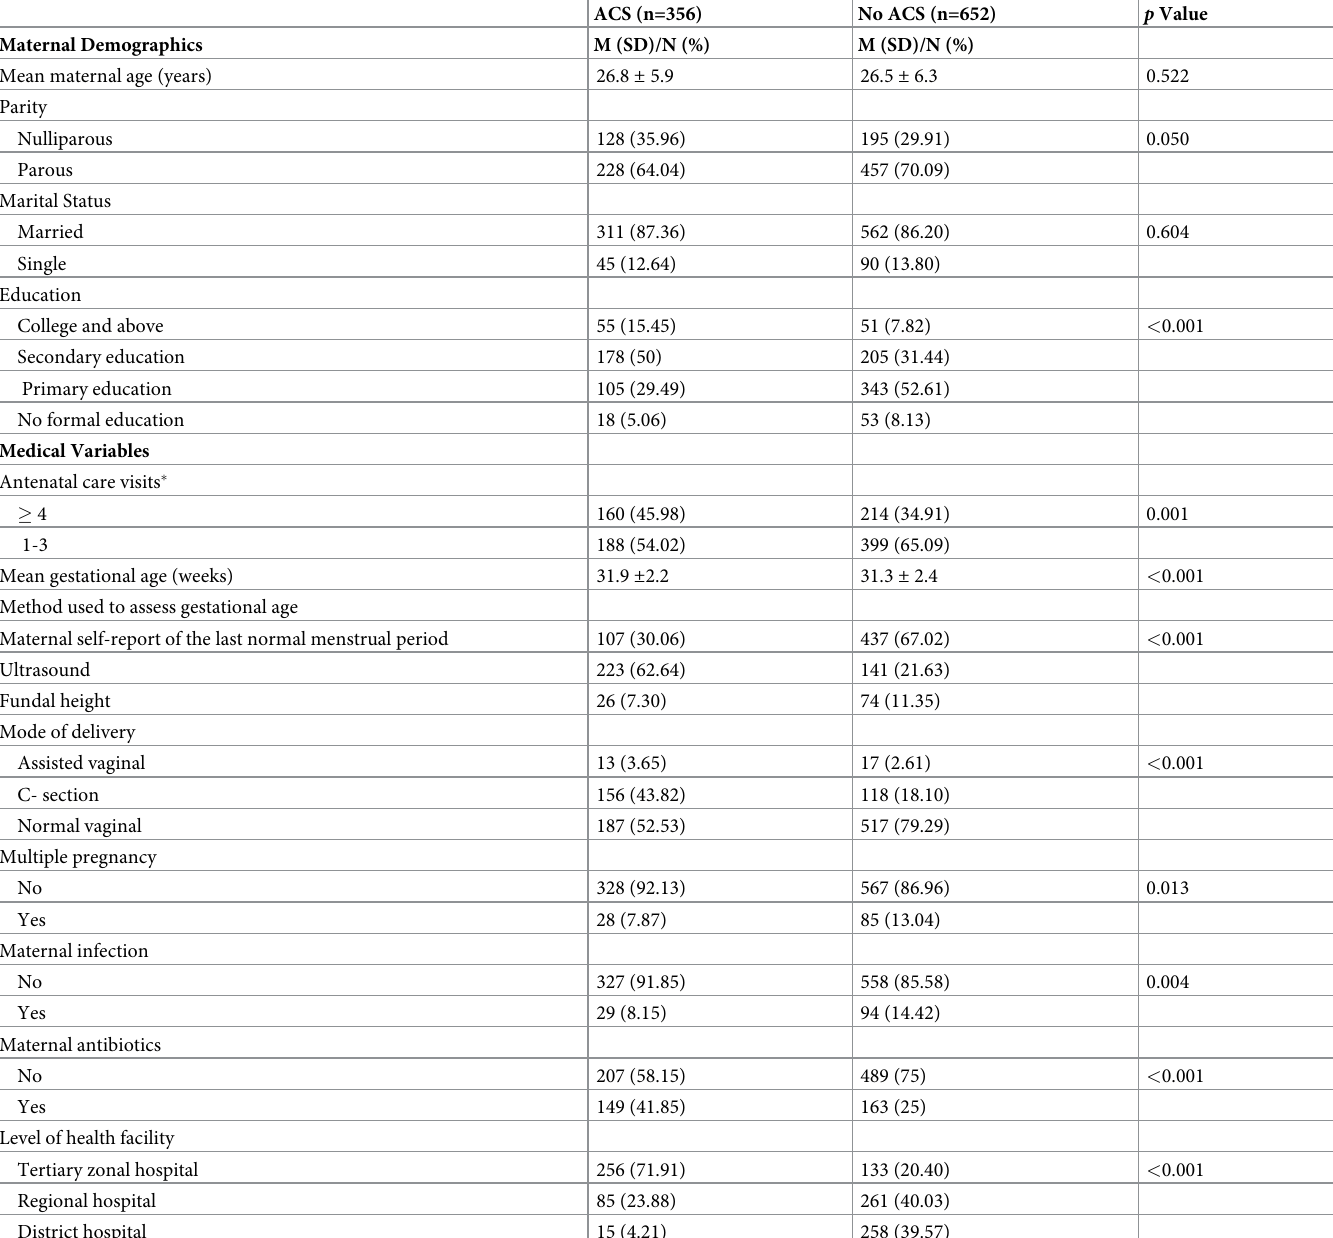
Table 1. Maternal demographic, medical and health facility characteristics by ACS